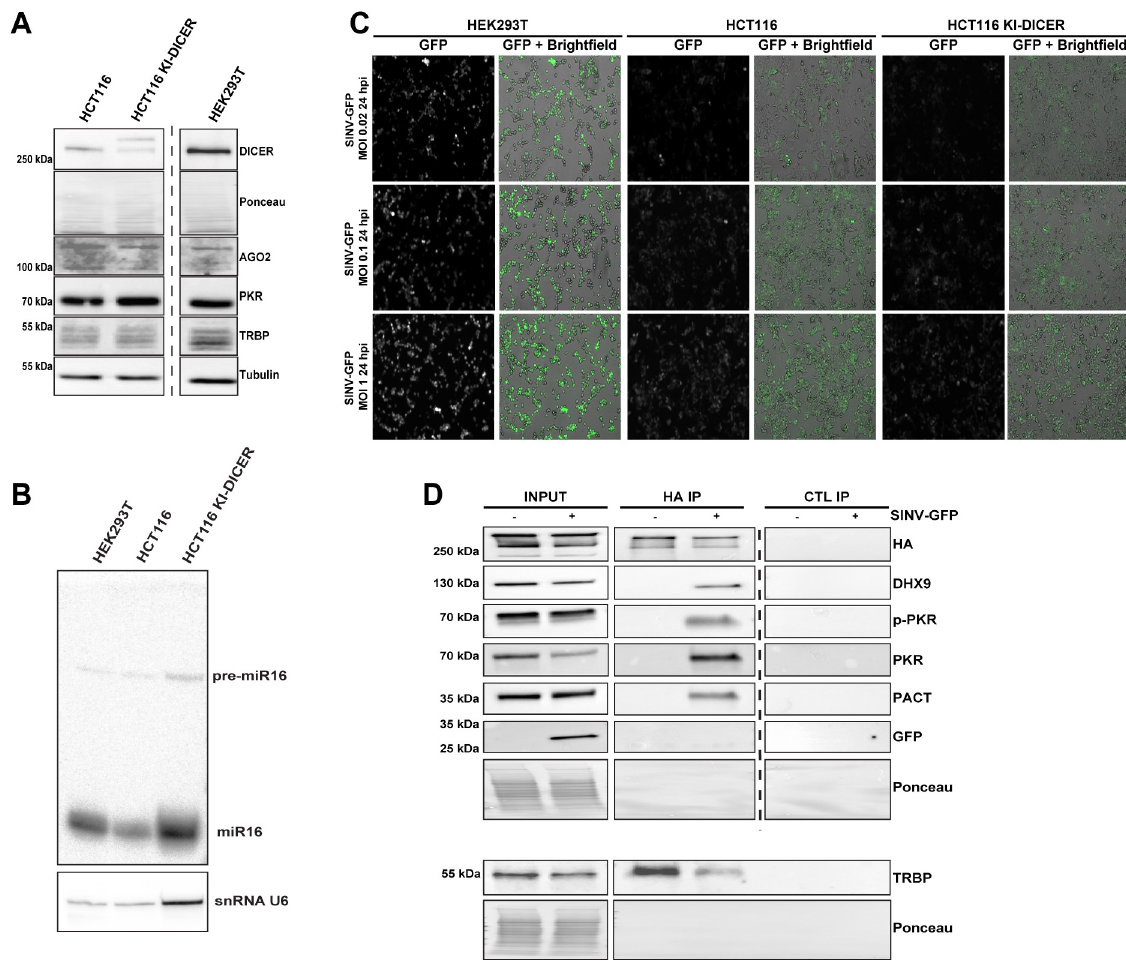
Fig 4. Confirmation of DICER interactome upon SINV infection in HCT116 KI-DICER cells. A. Western blot analysis of DICER, AGO2, PKR and TRBP expression in HEK293T, HCT116 and HCT116 KI-DICER cell lines. Gamma-Tubulin and ponceau were used as loading controls. B . GFP fluorescent microscopy pictures of HEK293T, HCT116 and HCT116 KI-DICER cell lines infected with SINV-GFP at an MOI of 0.02, 0.1 and 1 for 24 h. The left panel corresponds to GFP signal from infected cells and the right panel to a merge picture of GFP signal and brightfield. Pictures were taken with a 5x magnification. C . miR-16 expression analyzed by northern blot in the same cell lines as in B. Expression of snRNA U6 was used as loading control. D. Western blot analysis of HA co-IP in mock or SINV-GFP-infected (MOI of 0.1, 24 hpi) HCT116 KI-DICER cells. Proteins associated to FHA-GFP:DICER were revealed by using antibodies targeting endogenous DHX9, p- PKR, PKR, PACT or TRBP proteins. The TRBP immunoblot was performed by loading the same samples on a separate membrane. In parallel, an HA antibody was used to verify the IP efficiency and GFP antibody was used to verify the infection. Ponceau was used as a loading control.